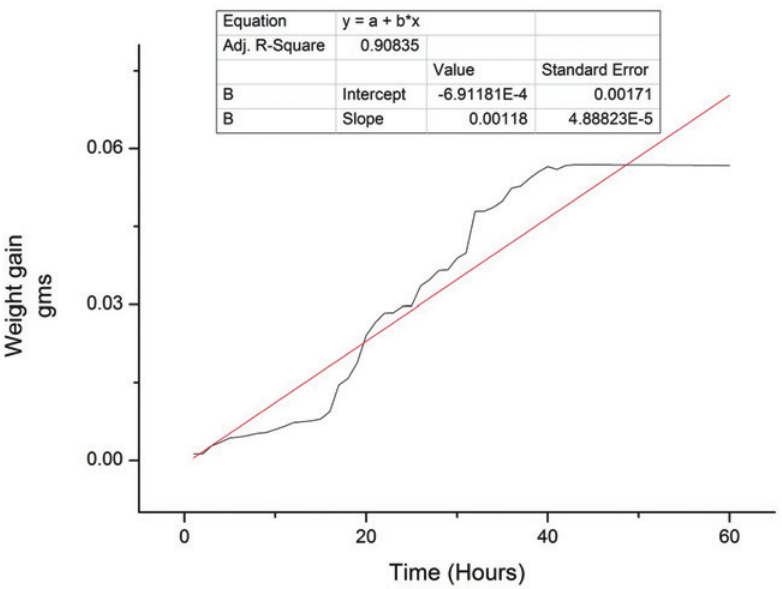
Figure 6: Plot of weight gain as a function of time during oxidation of coated samples.